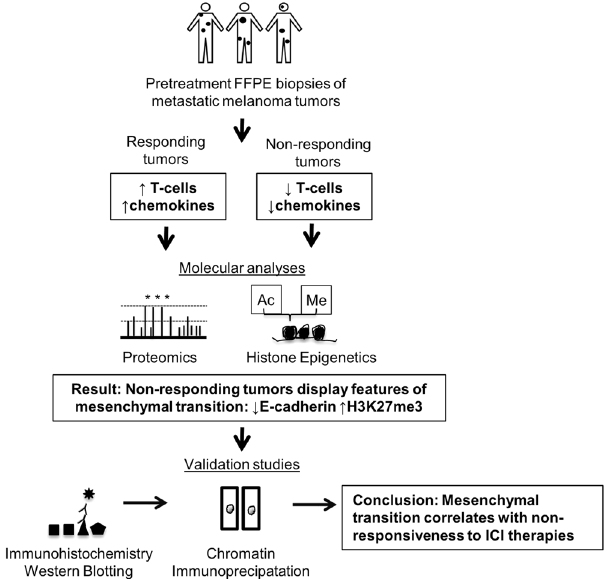
Figure 5. Indicators of responsiveness to immune checkpoint